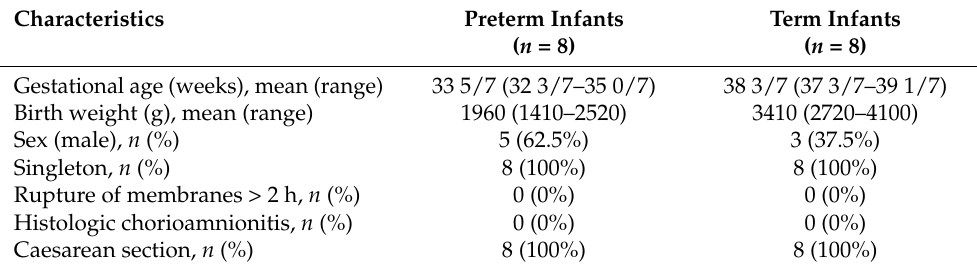
Table 1. Baseline characteristics of preterm and term cord blood